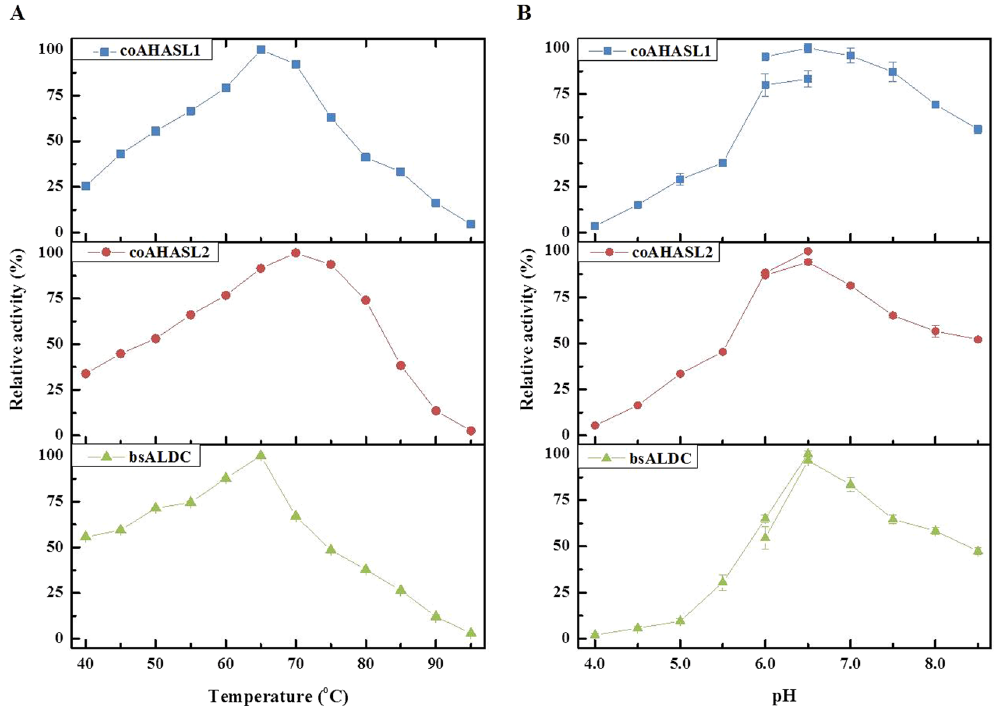
Figure 3. Temperature and pH profiles of the recombinant enzymes involved in converting pyruvate to acetoin. ( A ) Optimum temperatures of coAHASL1, coAHASL2 and bsALDC. ( B ) Optimum pH values of coAHASL1, coAHASL2 and bsALDC. Error bars indicate standard deviations of three independent experiments.